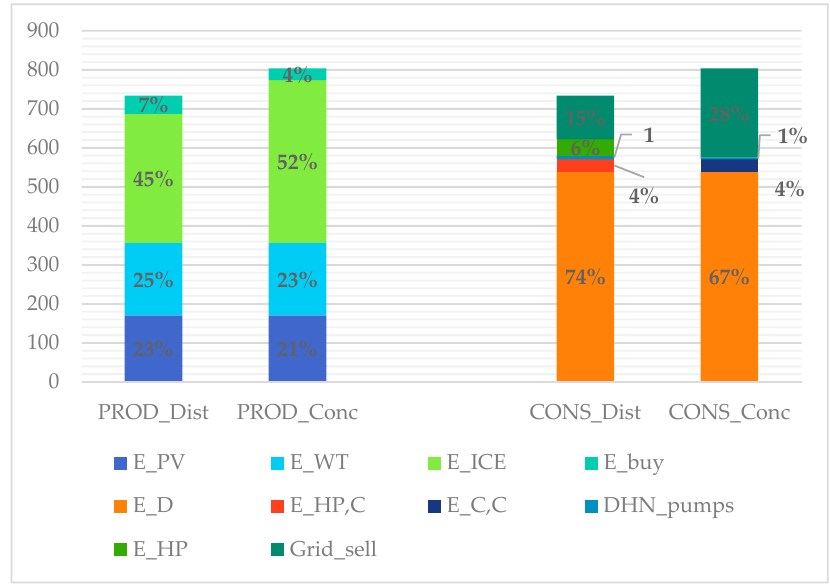
Figure 7. Thermal energy balance (MWh/yr).